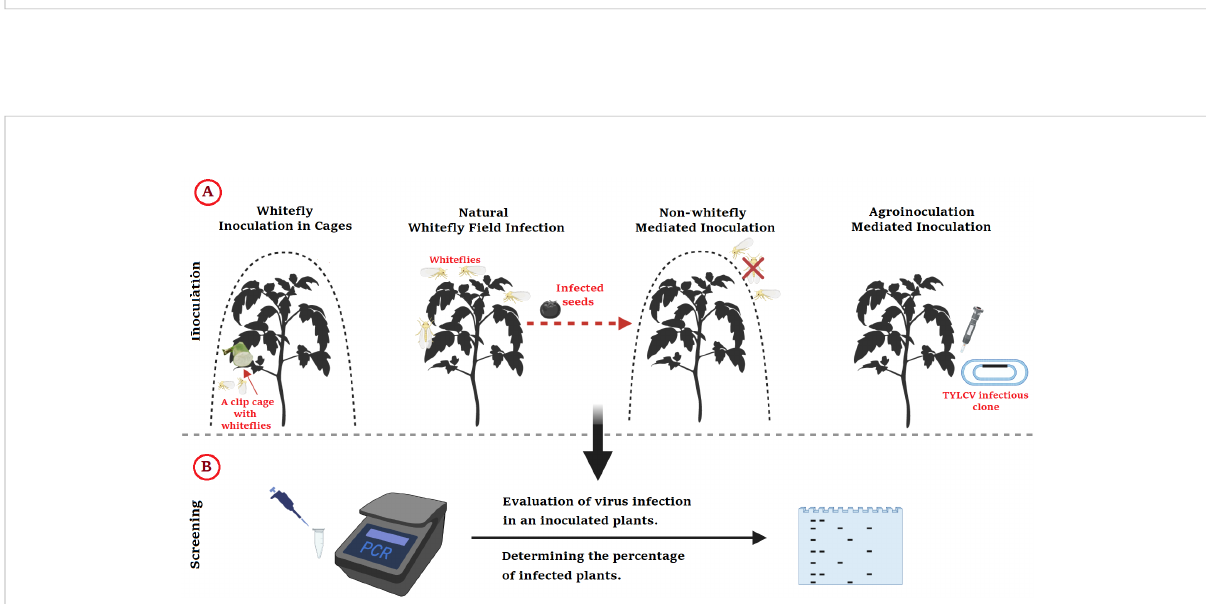
FIGURE 3 Methods for Identifying Resistance to TYLCV in Tomato; (A) Inoculation types, followed by (B) PCR screening method. This fi gure was made using BioRender.